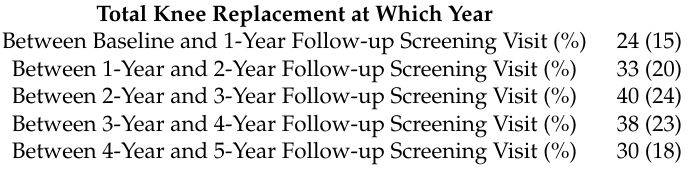
Table 2. Descriptive data of the 165 study participants at the following time points prior to the